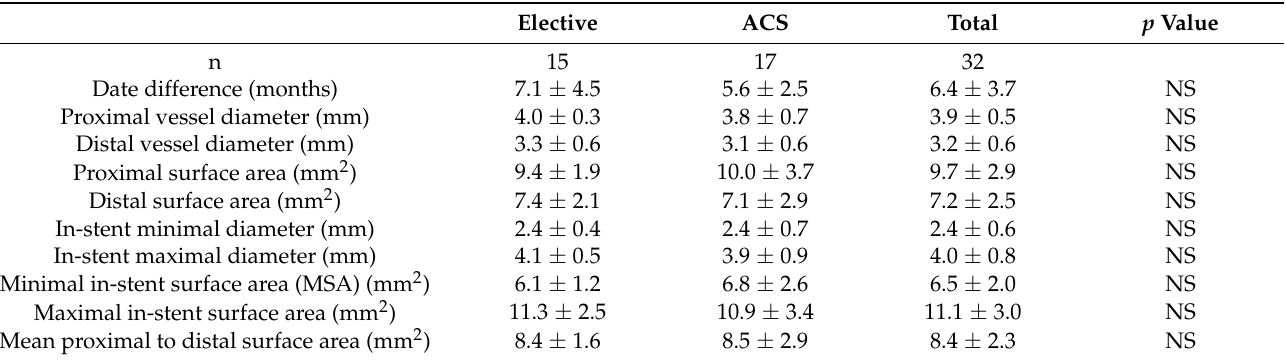
Figure 4. Cross sectional cut of a proximal left anterior descending artery and in-stent minimal lumen area. The two radiopaque spots (stars) are the tantarum markers at the proximal and distal edges of the stent with no discernible struts. Points A and B refer to cross sections at the respective levels. Table 5. Coronary computed tomography